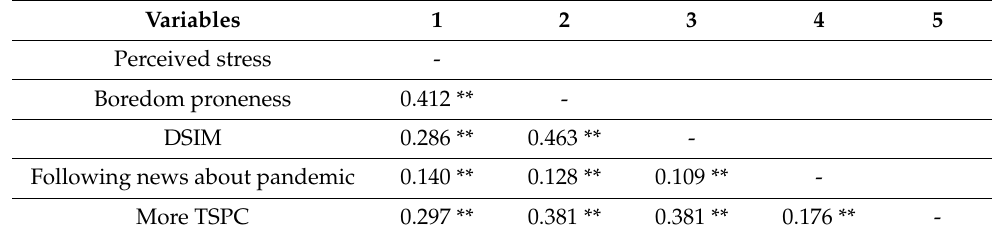
Table 3. Correlation matrix of research variables: perceived stress, boredom proneness, DSIM, following news about the pandemic, and more TSPC.